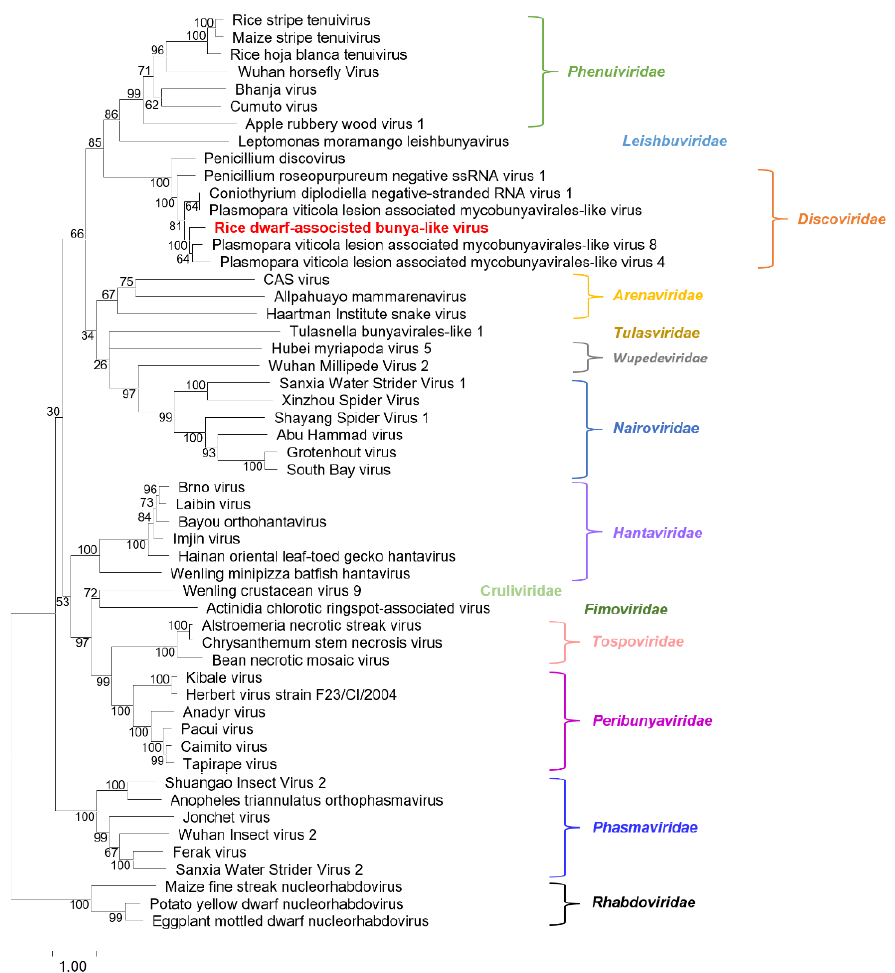
Figure 3. Phylogenetic tree analysis of the RNA-dependent RNA-polymerase of RDaBV and representative viruses from the orders Bunyavirales and Mononegavirales . The tree was inferred using the maximum likelihood method and a JTT matrix-based model with 1000 bootstraps. The number represents the bootstrap value of each branch. Viruses from the same family are shown in the same color. The name RDaBV is shown in red. Detailed information about the viruses used in the analysis is listed in Table S3.